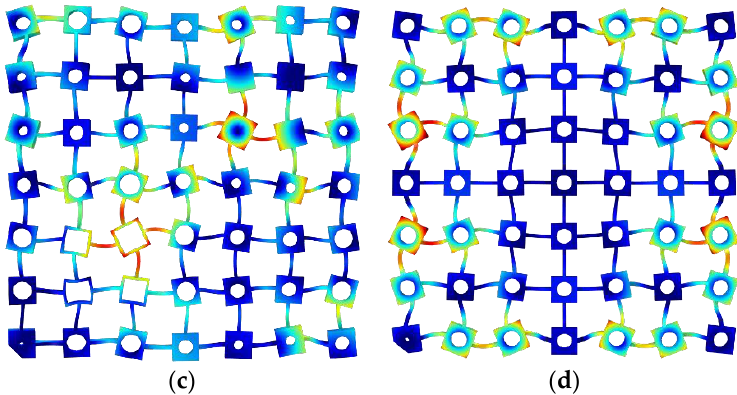
Figure 3. Mode shapes of the metamaterials at the start and end frequencies of the bandgaps: the rainbow metamaterial at ( a ) 444 Hz and ( c ) 578 Hz, and the periodic metamaterial at ( b ) 466 Hz and ( d ) 549 Hz.